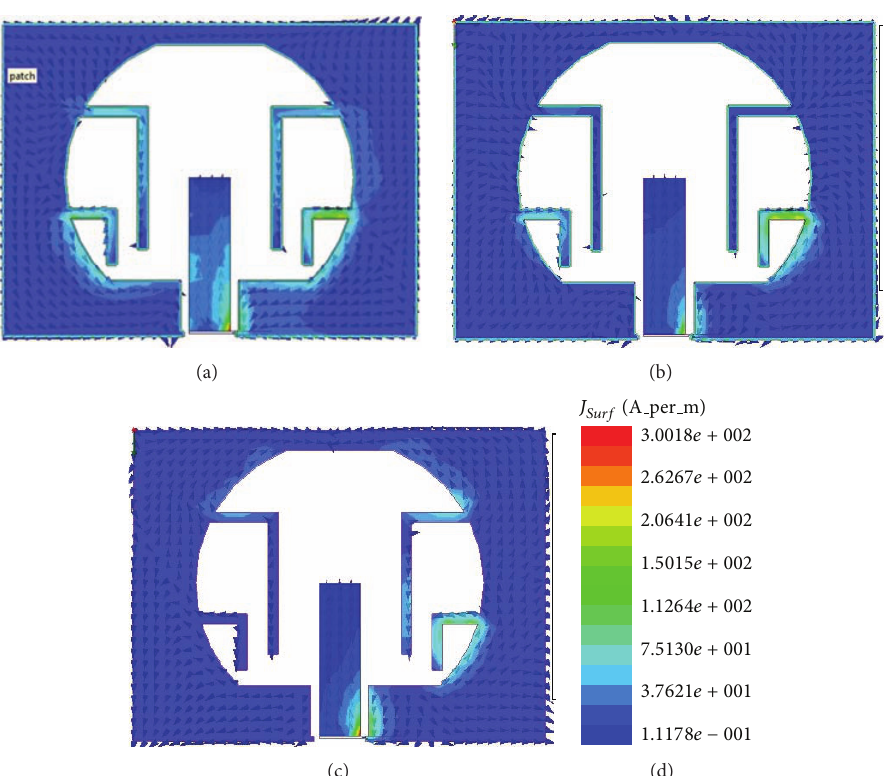
Figure 8: Simulated surface current distribution of proposed antenna at (a) 3.70 GHz, (b) 5.2 GHz, and (c) 5.8 GHz (d)